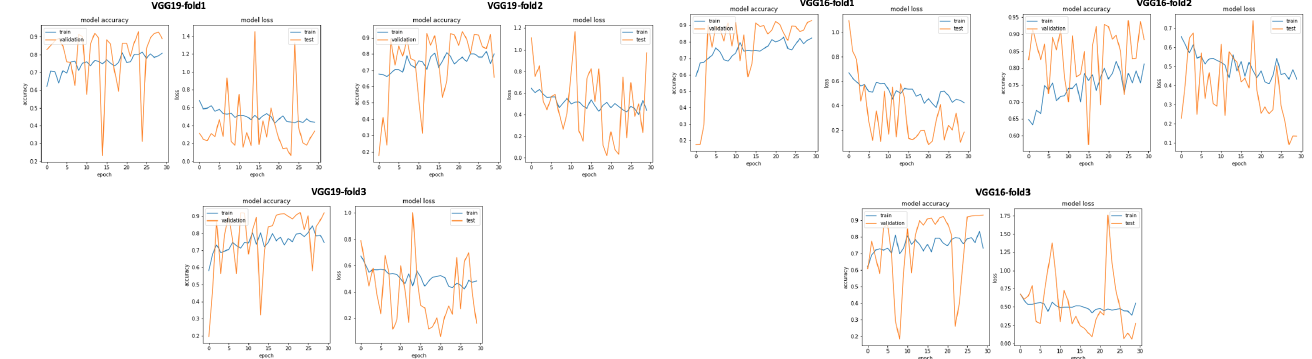
Figure 25. VGG19 abd VGG16 training and validation curves using data selection based on